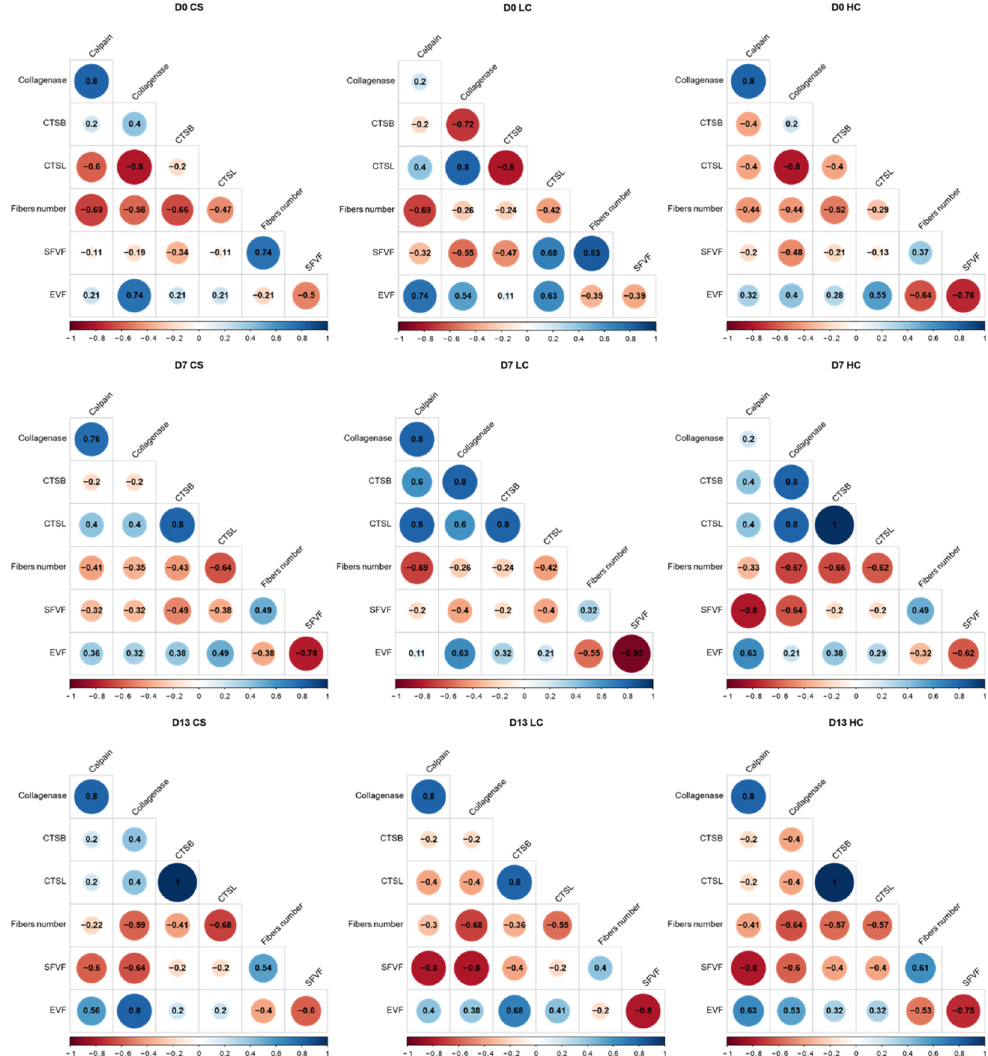
Figure 9. Pairwise correlation coefficients of proteolytic enzymes and muscle fiber properties in the control group (D0 CS: control group day 0, D7 CS: control group day 7 post-harvest, D13 CS: control group day 13 post-harvest), low current treatment group (D0 LC: low current treatment group day